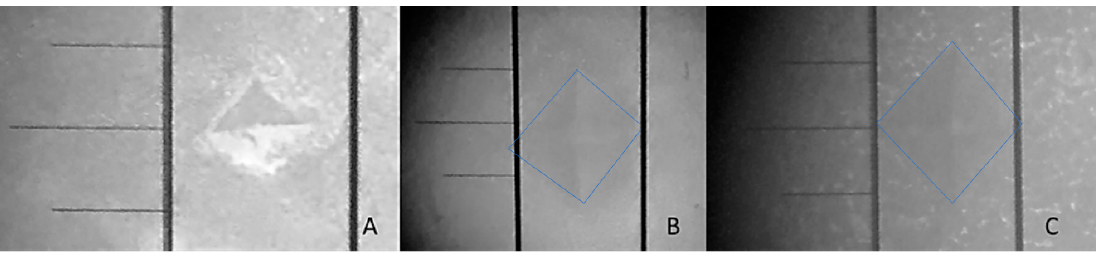
Figure 2. ( A ) Indentation from Group B: ( B ) Indentation from Group D where the mark is bigger than the previous image, ( C ) Indentation from Group F, showing a softer surface for a greater indentation. Table 3. Correlation between decreased mineralization and microhardness value.